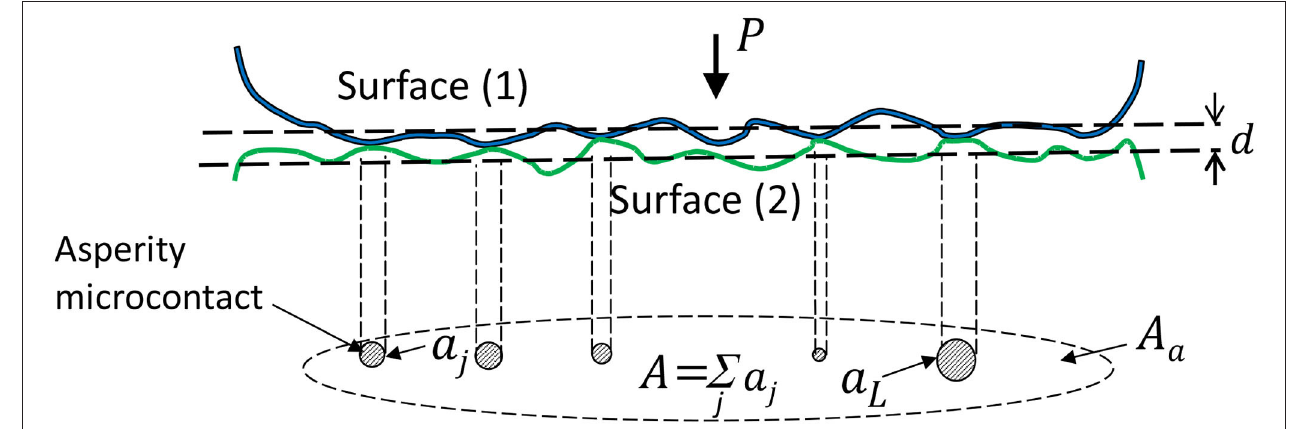
FIGURE 4 | A model of two rough surfaces under load showing that actual contact occurs at asperity microcontacts of various sizes.